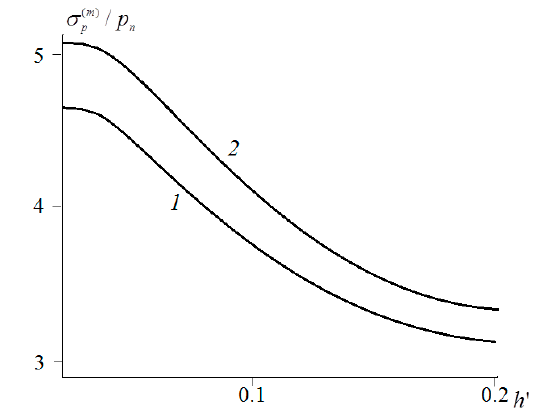
Figure 5. Dependence of the reduced-stresses maximum on the layer thickness: c = 5, ν = 0.4,